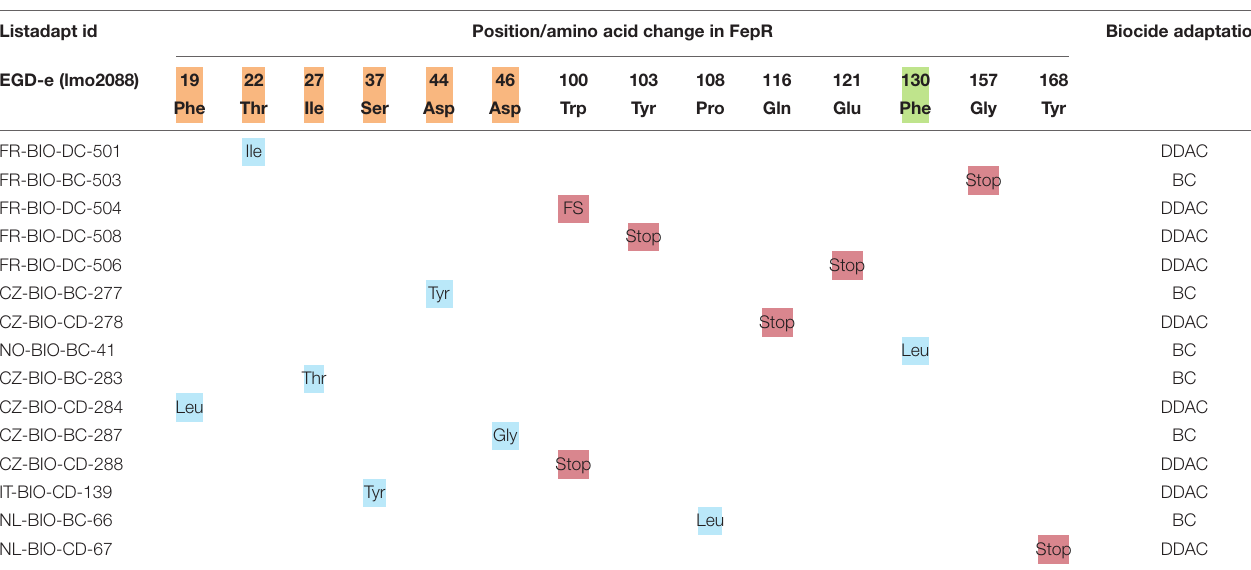
TABLE 3 | Amino acid changes in the FepR